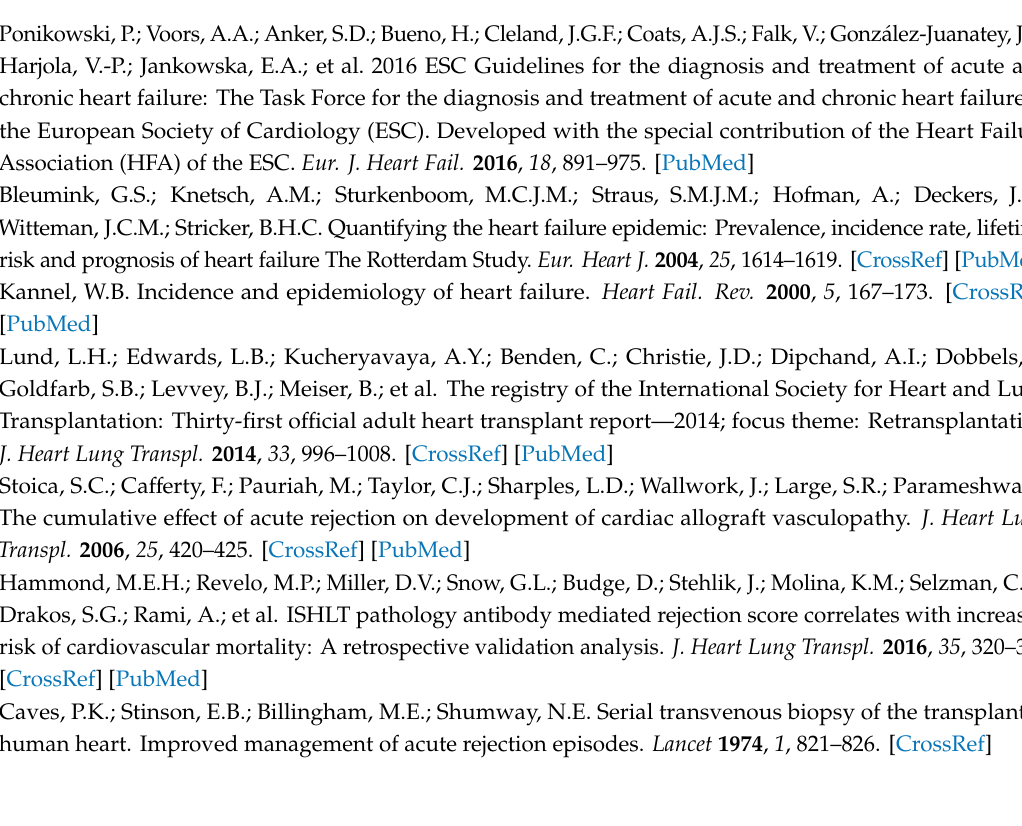
Supplementary Table S3: Principal component analysis workflow. Sequencing data are available at the authors upon